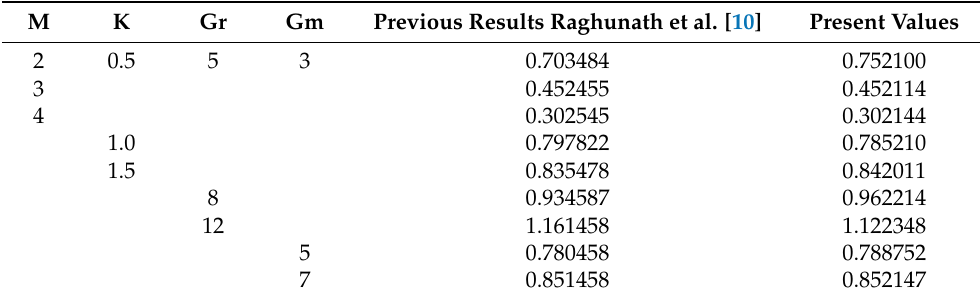
Table 4. Comparison of results for primary velocity (A = 5, n = 0.5, t = 0.5, є = 0.01, U 0 = 0.5, Sc = 0.22, Kc = H = Q 1 = F = 1, Du =